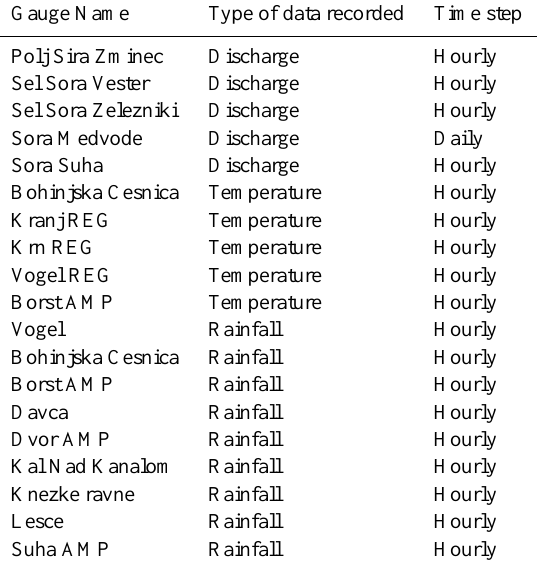
Table 5. Gauges with available data, type of records and time-step. Gauge